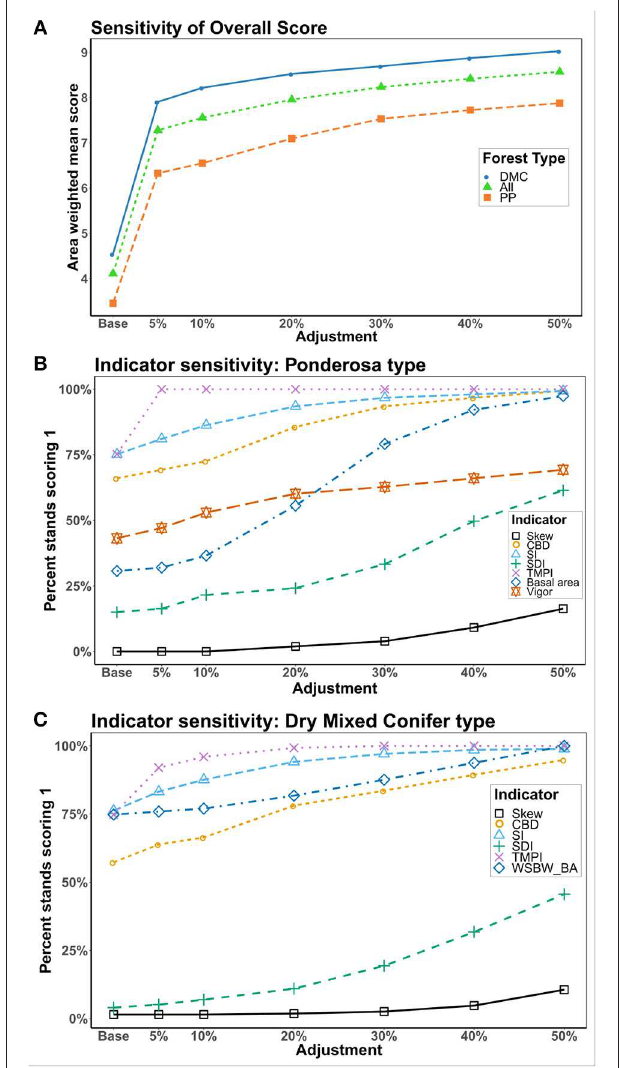
FIGURE 4 | (A) Change in the overall area-weighted mean resilience score in response to adjustments in indicator values. (B,C) Forest Type-specific ( B : Ponderosa pine and C : Dry mixed conifer) change in indicator values in response to adjustments. The y-axis gives the percentage of stands scoring a 1, meaning they were on the resilient side of the threshold, for each indicator. Only indicators with continuous responses are included in the